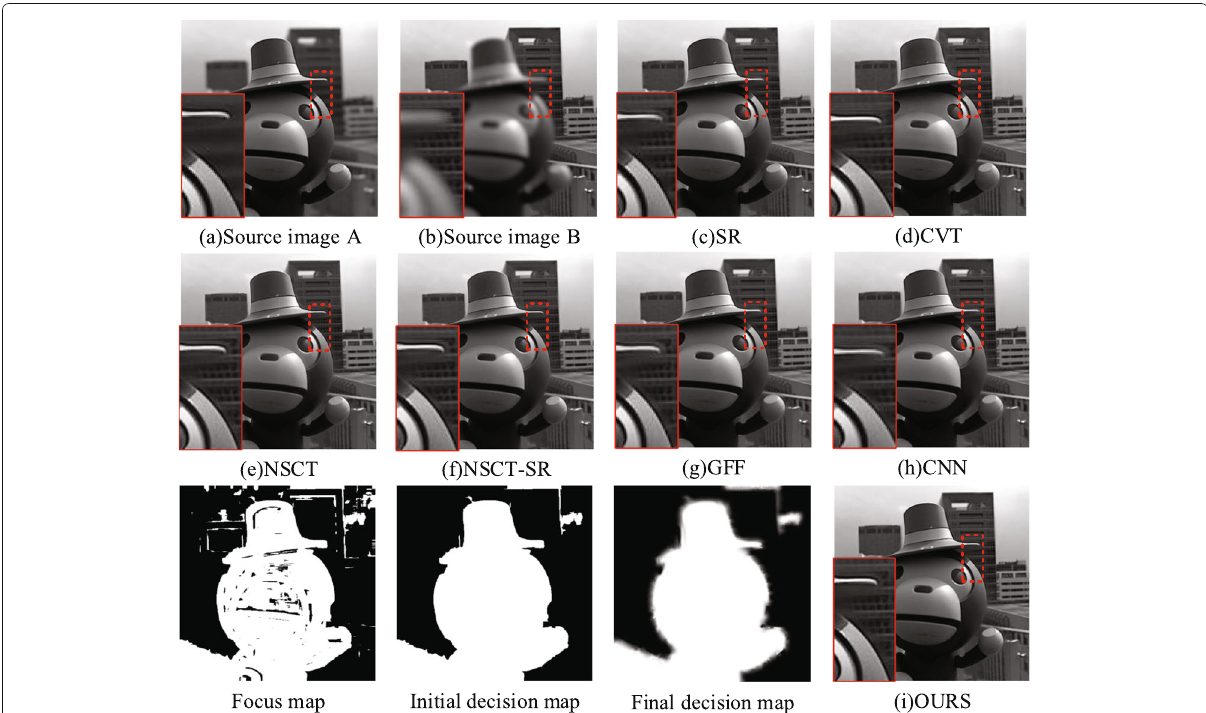
Fig. 8 Fused results of “Toy” source images. Fusion results of different methods of “Toy” source images are presented. The border area of each fused image between focused and non-focused is displayed in the lower left corner to clearly distinguish the difference. Intermediate fusion results of our methods are shown as focus map and decision map